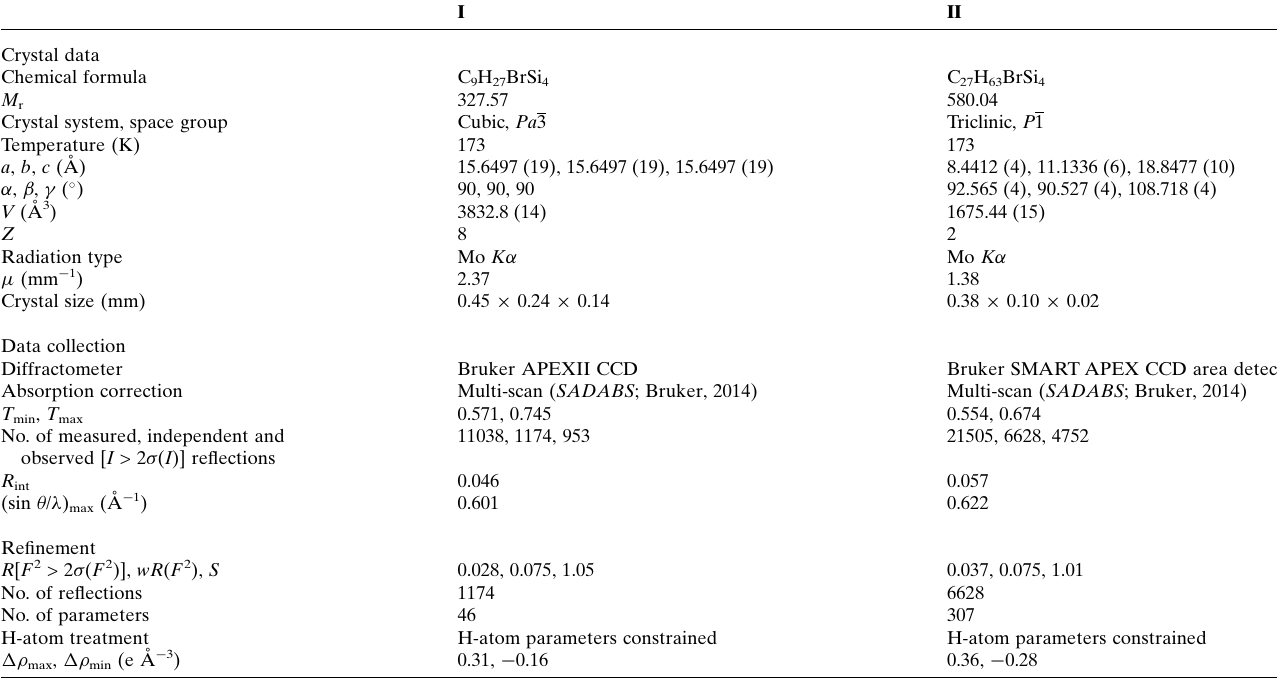
Crystal data Chemical